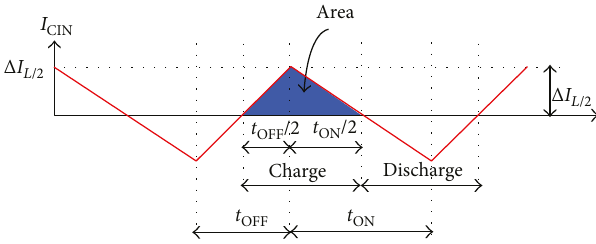
Figure 18: Current waveforms of the input capacitor in CCM.